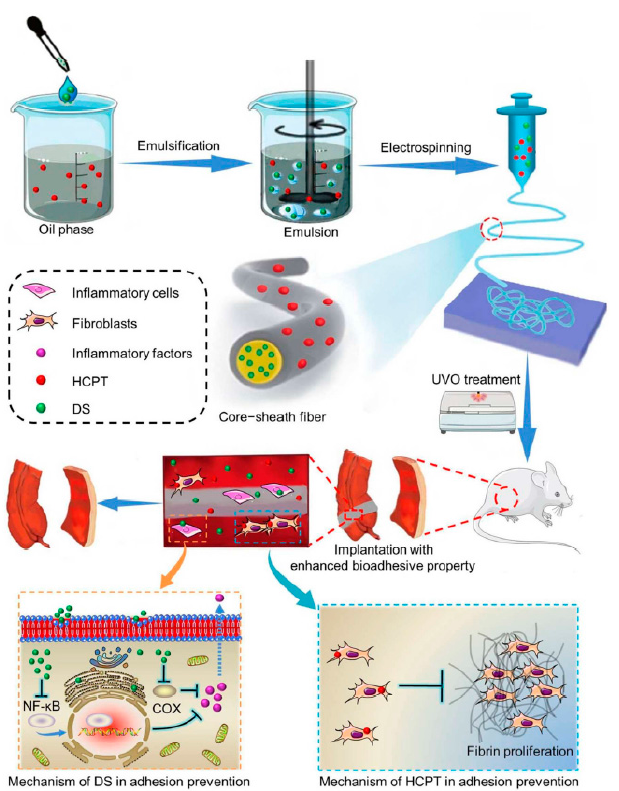
Figure 19. Schematic of preparation and anti-adhesion of HCPT and DS co-loaded NFs for implanta- tion. Reproduced with permission from [116], Copyright © 2021, American Chemical